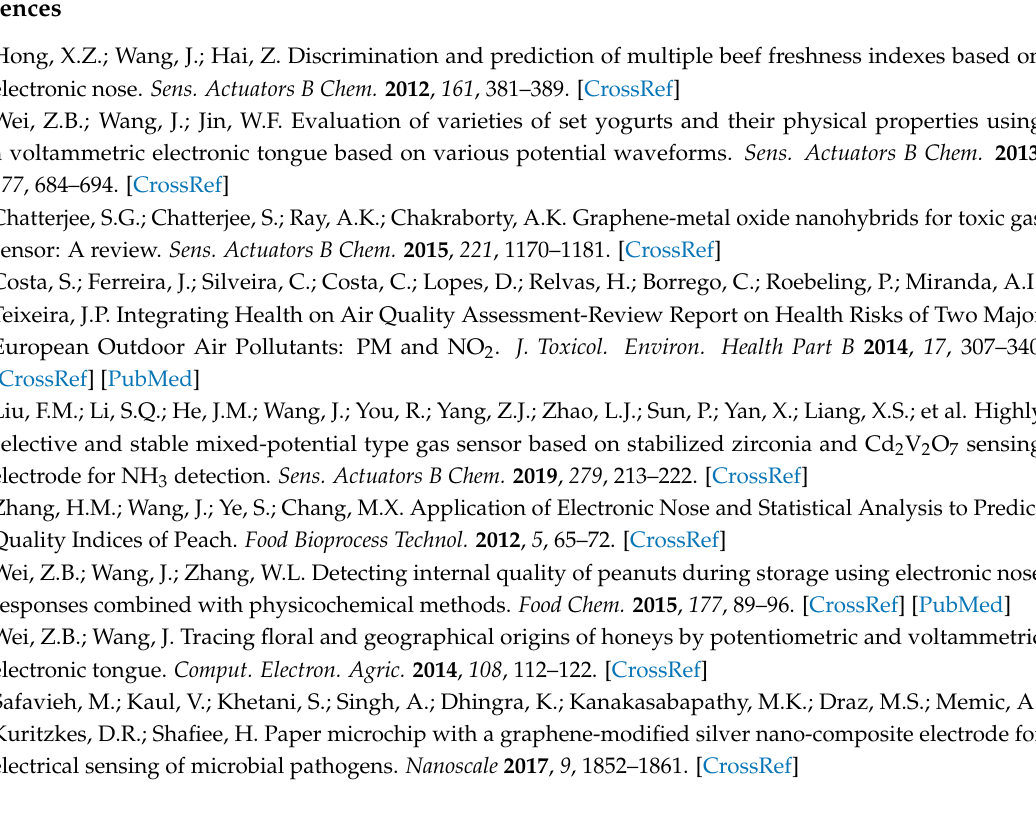
Figure S1: title, Table S1: title, Video S1: